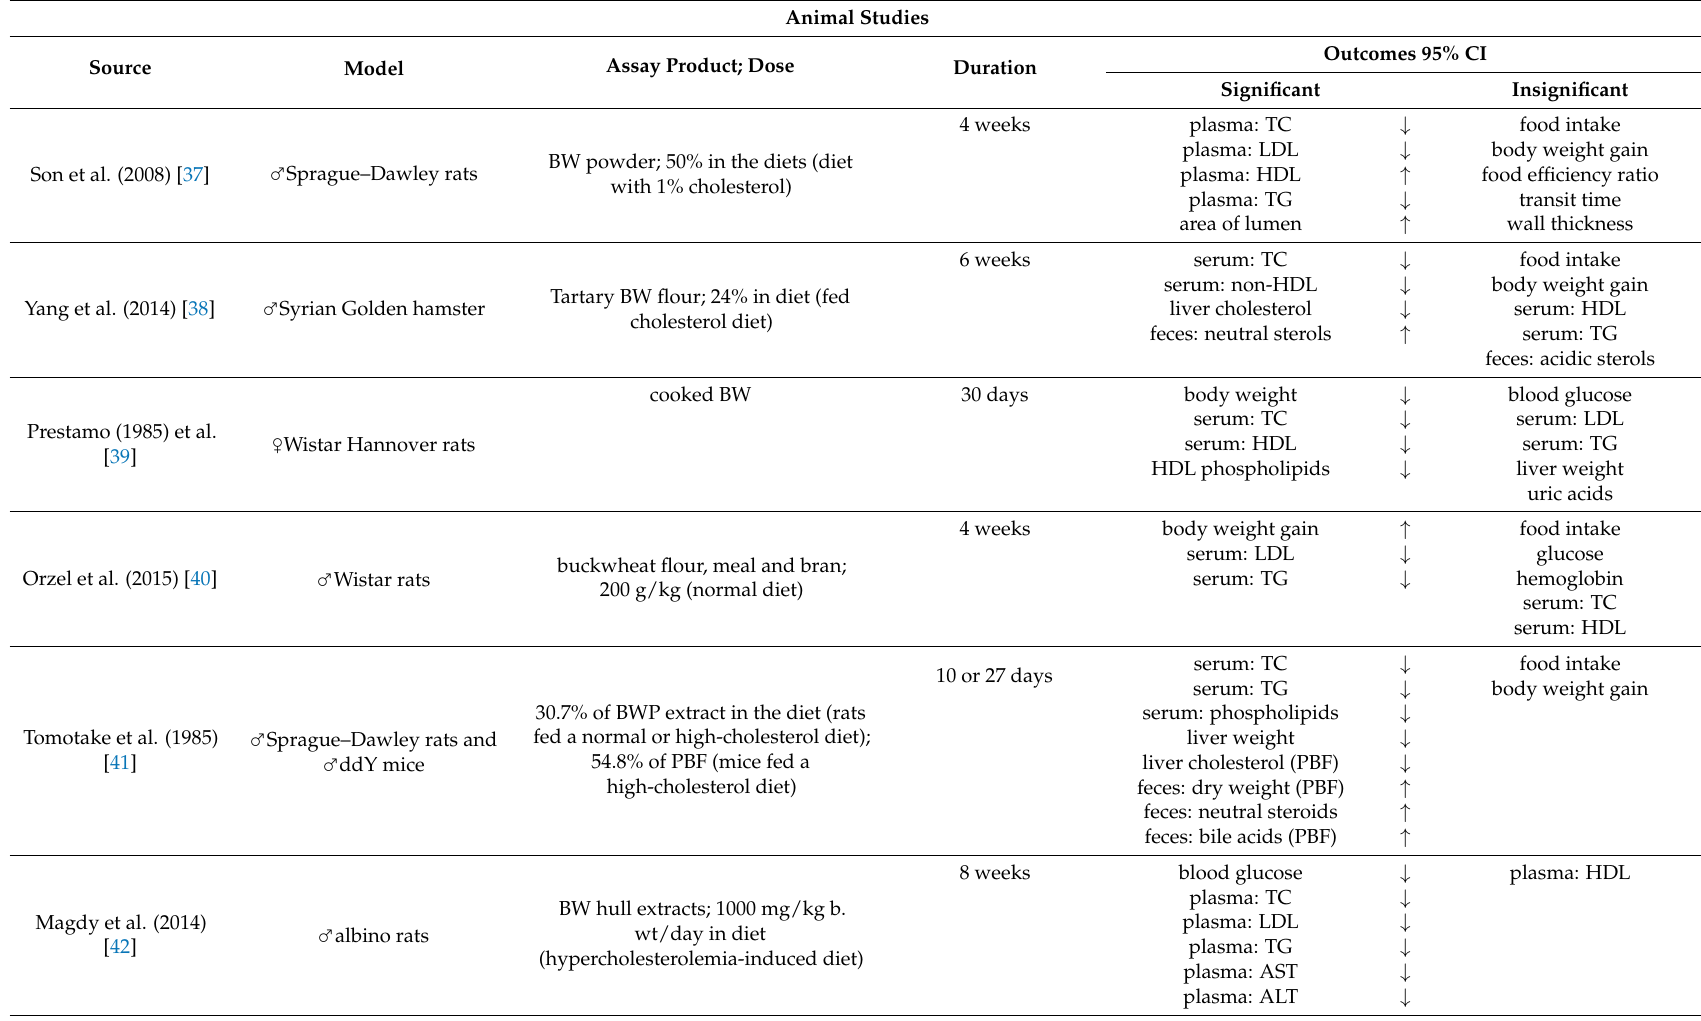
Table 2. Summary of all animal studies